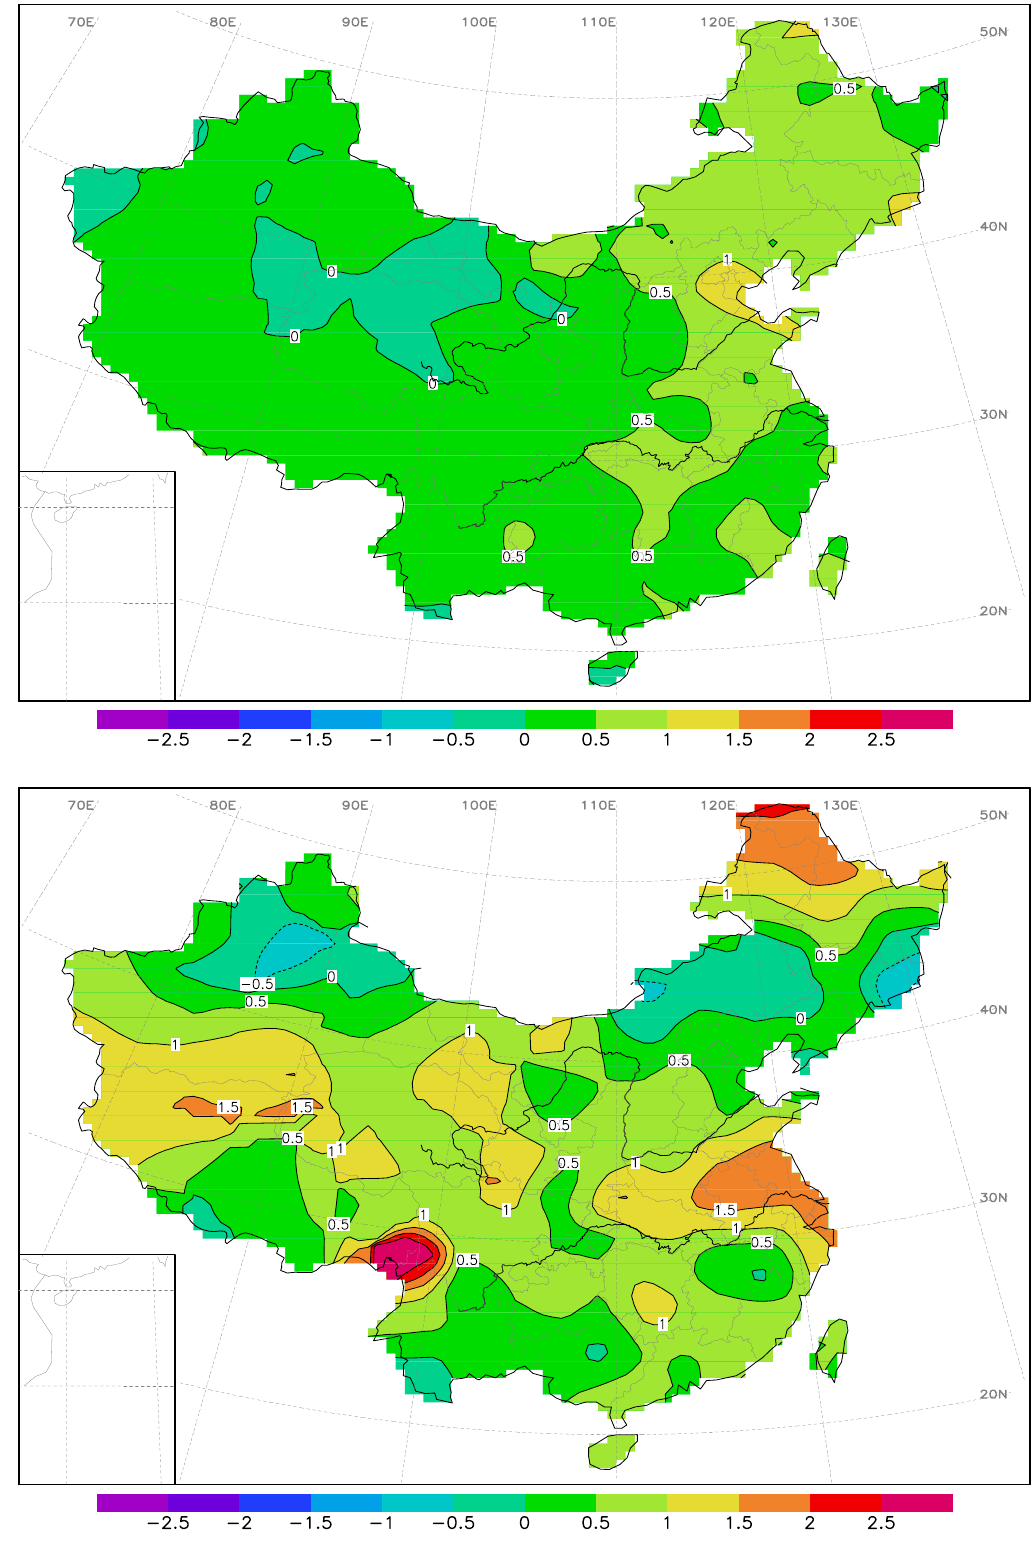
Fig. 3. Monthly temperature anomalies in July 1998 forecasted by the M1 (upper) and observations Figure 3. in ANGEO_05134